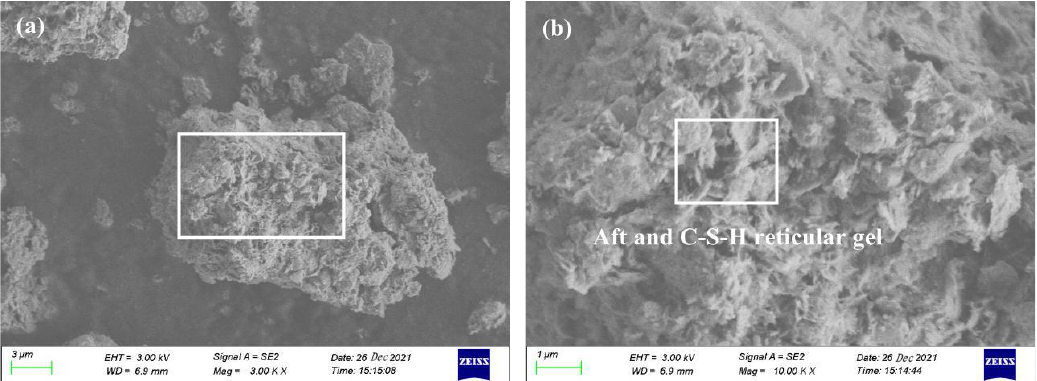
Figure 12. Ordinary-cemented soil cured for 60 d. ( a ) (3.00 kx magnification) and ( b ) (10.00 kx magnification).